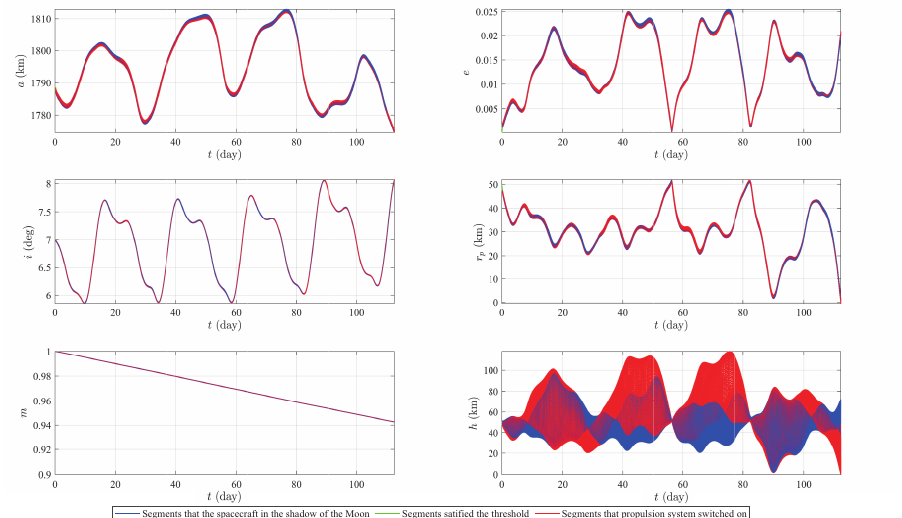
Figure 8. The variation of orbit elements in the process of orbit maintenance with thrust (cid:107) T (cid:107) = 10 mN, Ω = 240 ◦ and i = 7 ◦